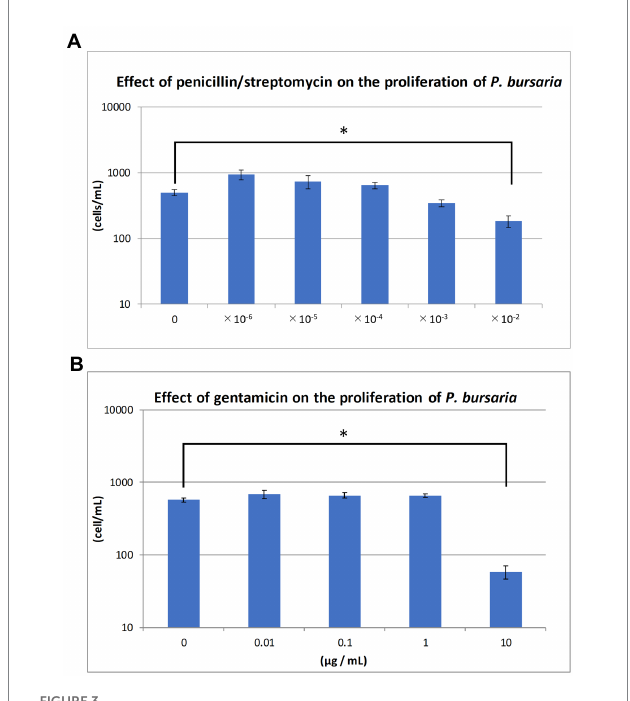
FIGURE 3 Effects of antibiotics on the proliferation of unfed culture strains. The abscissa indicates the concentrations of the penicillin/streptomycin mixture and gentamicin for (A) and (B) , respectively. The ordinate in (A) and (B) is the cell density (cells/mL) at 19 and 14 days after the start of culture, respectively. Asterisks indicate that differences are statistically significant from each